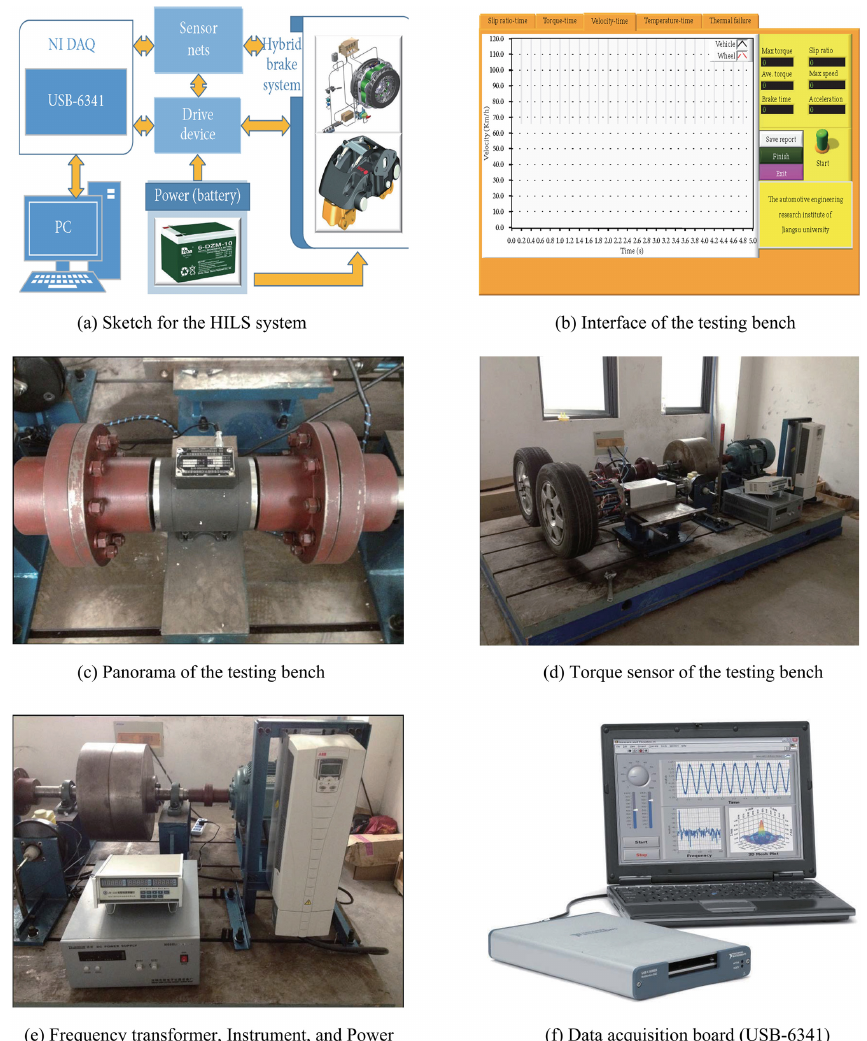
Figure 5. Hardware in the loop simulation platform of the electromagnetic and frictional integrated brake